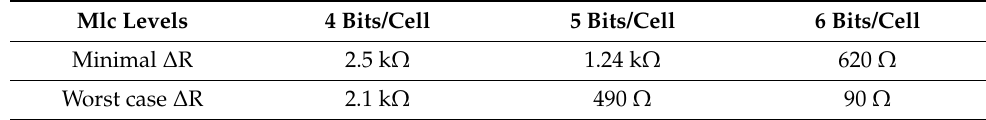
Table 3. Projections beyond quad-level